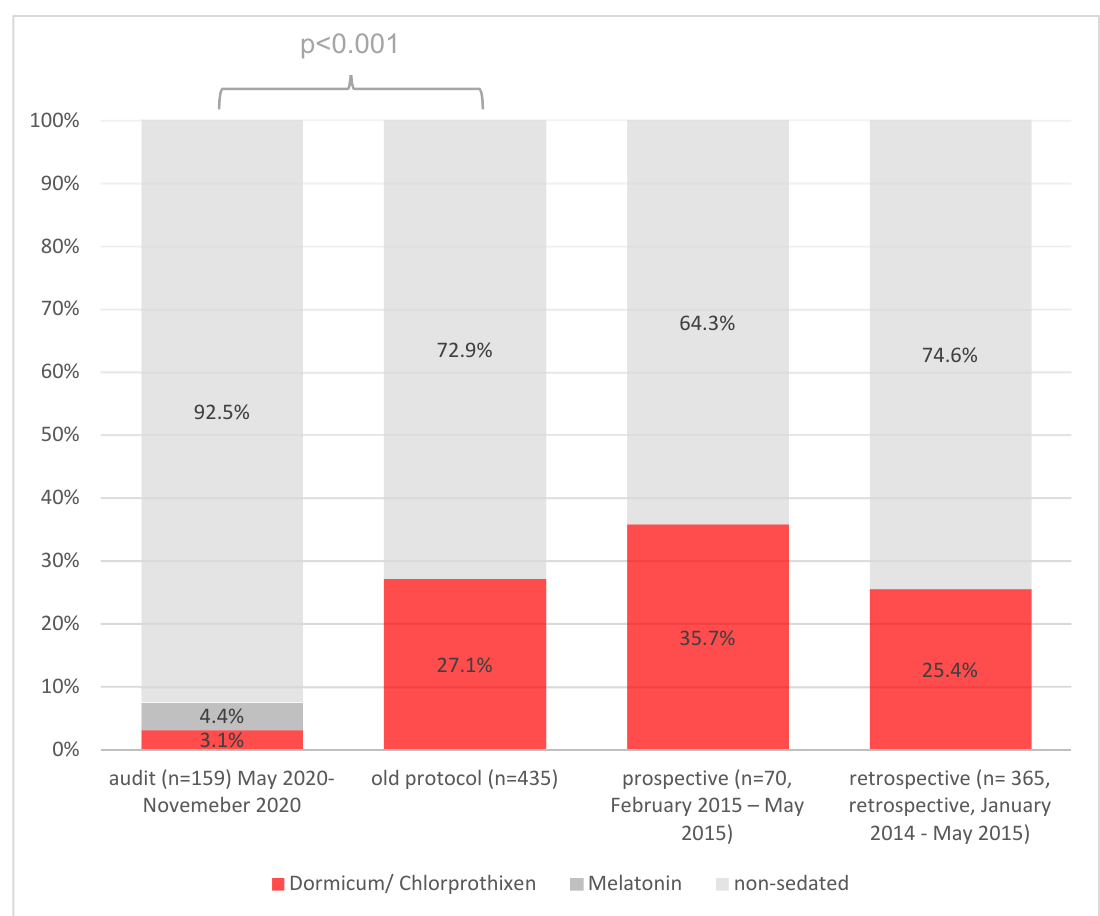
Figure 2. Percentage of sedation rate in nuclear medicine examinations within the retrospective, prospective and current audit analysis. p > 0.001 refers to a comparison (chi 2 test) of sedation rates between the “audit” and “old protocol”